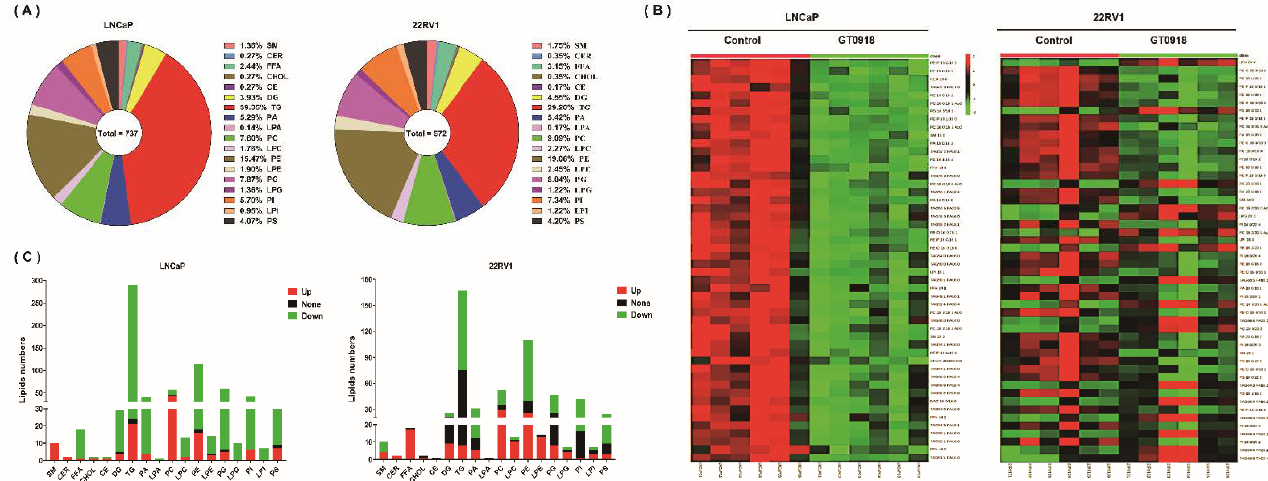
Figure 4. Lipidomic analysis to evaluate the effect of proxalutamide (GT0918) on PCa cells. ( A ) The total number and proportion of detected lipids of eighteen classes in LNCaP and 22RV1 cells through LC–MS/MS analysis. ( B ) Heat map of the intracellular content of the first 50 discriminant lipids with the largest difference between the treated and untreated cells. The test LNCaP and 22RV1 cells were treated with proxalutamide or control vehicle, respectively ( n = 6). Red indicates a high content, and green indicates a low content. ( C ) The detailed number of lipids detected in each lipid category in LNCaP and 22RV1 cells, where red represents the number of lipids whose content was up-regulated after proxalutamide intervention, green represents down-regulated lipids and black represents lipids that did not change. SM: sphingomyelin; CER: ceramide; FFA: free fatty acids; CHOL: cholesterol; CE: cholesterol ester; DG: diglyceride; TG: triglyceride; PA: phosphatidic acid; LPA: lysophosphatidic acid; PC: phosphatidylcholine; LPC: lyso-phosphatidylcholine; PE: phosphatidylethanolamine; LPE: lyso-phosphatidylethanolamine; PG: phosphatidyl-glycerol; LPG: lyso-phosphatidylglycerol; PI: phosphatidylinositol; LPI: lyso-phosphatidylinositol; PS: phosphatidylserine.